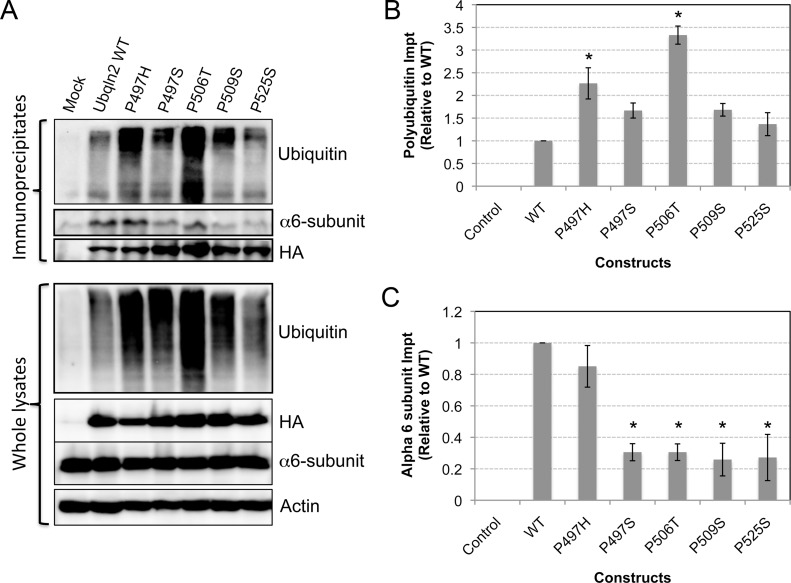
Ubiquilin-2 proteins containing ALS mutations bind polyubiquitinated proteins, but are defective in binding the proteasome.(A) HeLa cells were transfected with the HA-tagged ubiquilin constructs similar to Fig 1. 24 hrs after the transfection, lysates were made from each culture and divided into two equal portions. One set was used to immunoprecipitate the expressed HA-tagged ubiquilin-2 proteins using a polyclonal anti-HA antibody. Equal amounts of the precipitates were then examined for immunoprecipitation of the HA-tagged ubquilin-2 proteins and for co-immunoprecipitation of ubiquitinated proteins (anti-ubiquitin) and the alpha 6-subunit of the proteasome. Equal amounts of protein from the remaining half of the lysates were immunoblotted for ubiquitin, HA, alpha 6-subunit, and actin. (B) Graph showing quantification of the polyubiquitin signal that was co-immunoprecipitated relative to the amount of HA-tagged ubiquilin-2 immunoprecipitated in each lane. This ratio was then normalized to that of WT ubiquilin-2. Errors bars show standard error of the mean. The * indicated the two mutants that bound significantly more polyubiquitin proteins (p<0.05). (C) Similar to B, but showing analysis for the alpha 6-subunit. The * indicates the four mutants that bound significantly less alpha 6-subunit compared with WT ubiquilin-2 (p<0.05).